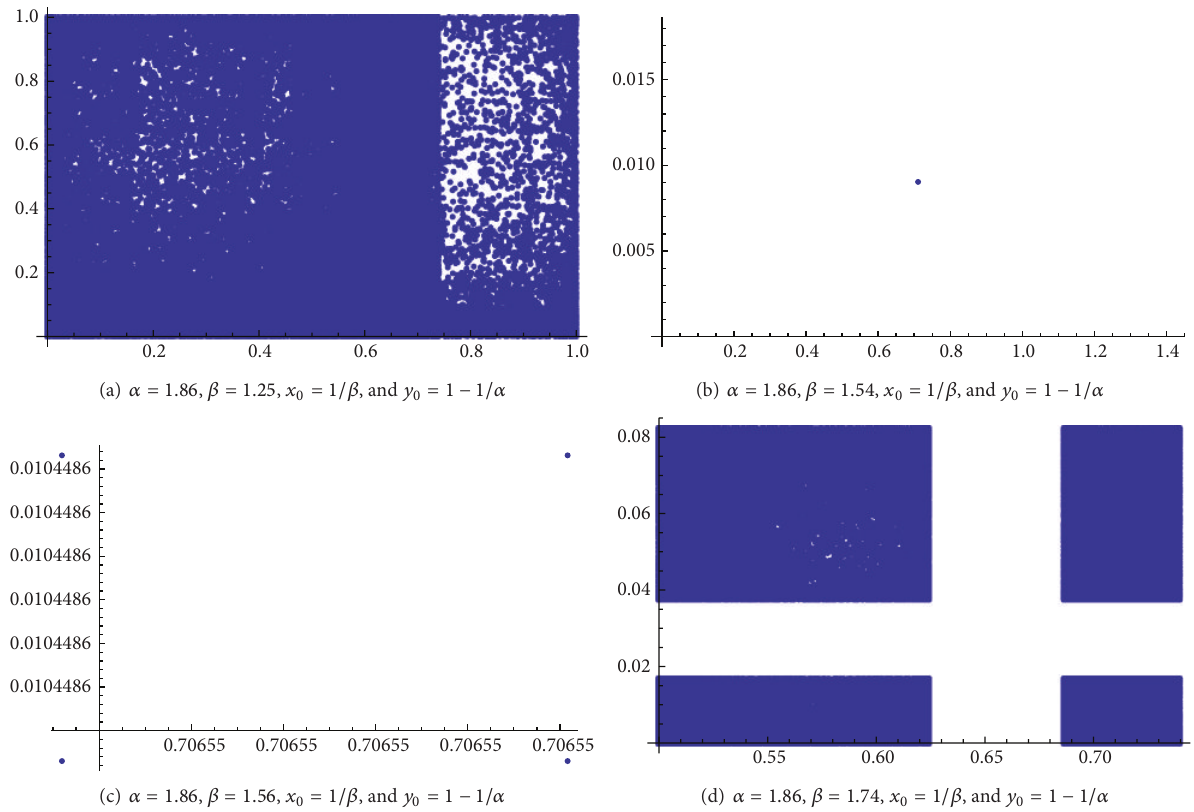
Figure 13: For 𝛼 = 1.86 we have drawn several different 𝜔 -limits. We make 200000 iterations and draw the last 100000 in the 𝑋𝑌 axis. We can see that for these parameter values the function is chaotic, but it could happen that the chaos is not physically observable.